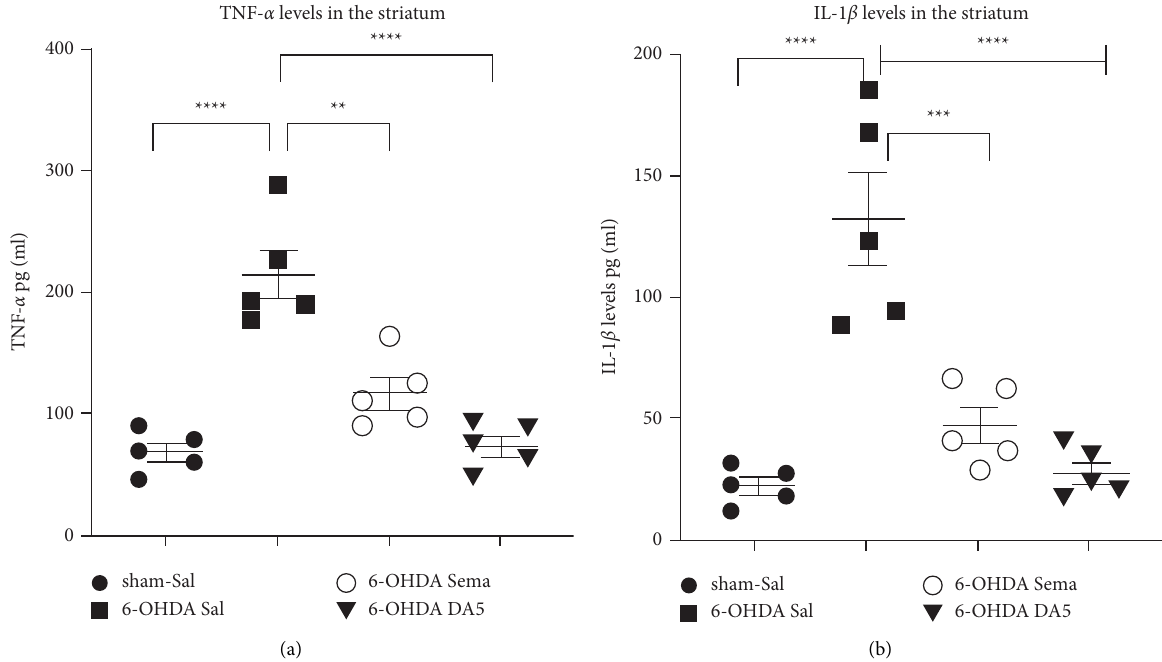
Figure 4: Efects of both drugs on the 6-OHDA-induced increase in striatal TNF- α and IL-1 β content. Te means ± SEM of 5 rats per group is shown. A one-way ANOVA followed by the Tukey multiple comparisons test; ∗∗ � p < 0 . 01; ∗∗∗ � p < 0 . 005; ∗∗∗∗ � p < 0 .